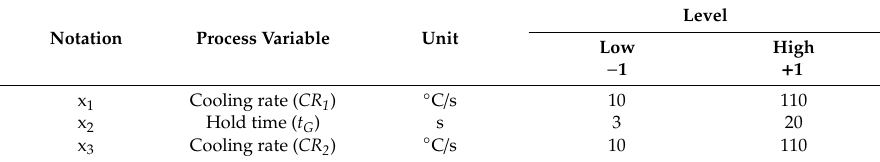
Table 2. Independent process variables and experimental design levels.